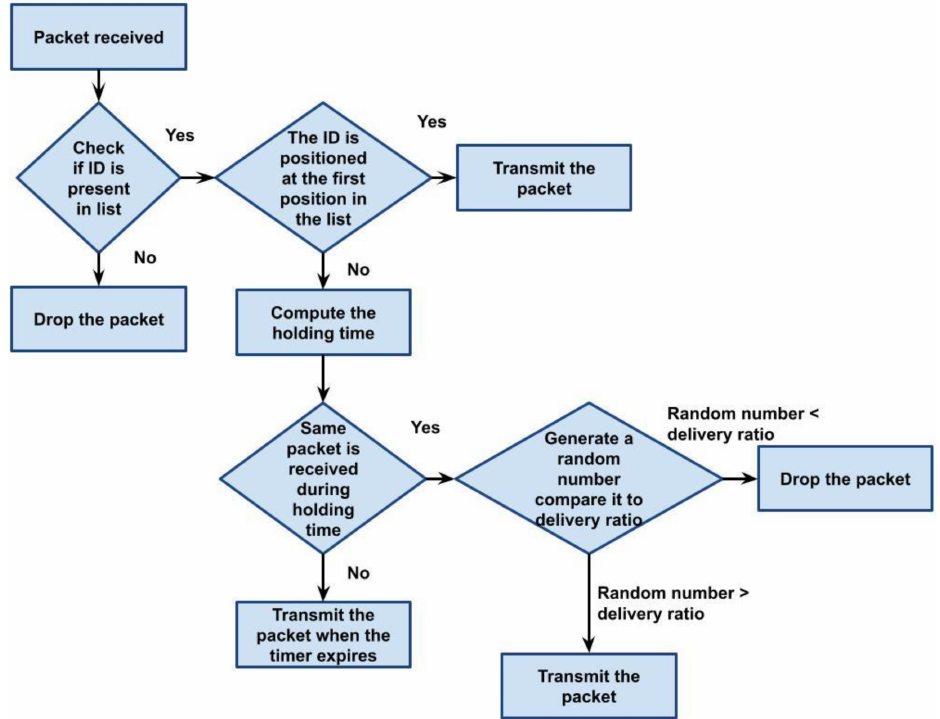
Figure 5. Proposed data transmission